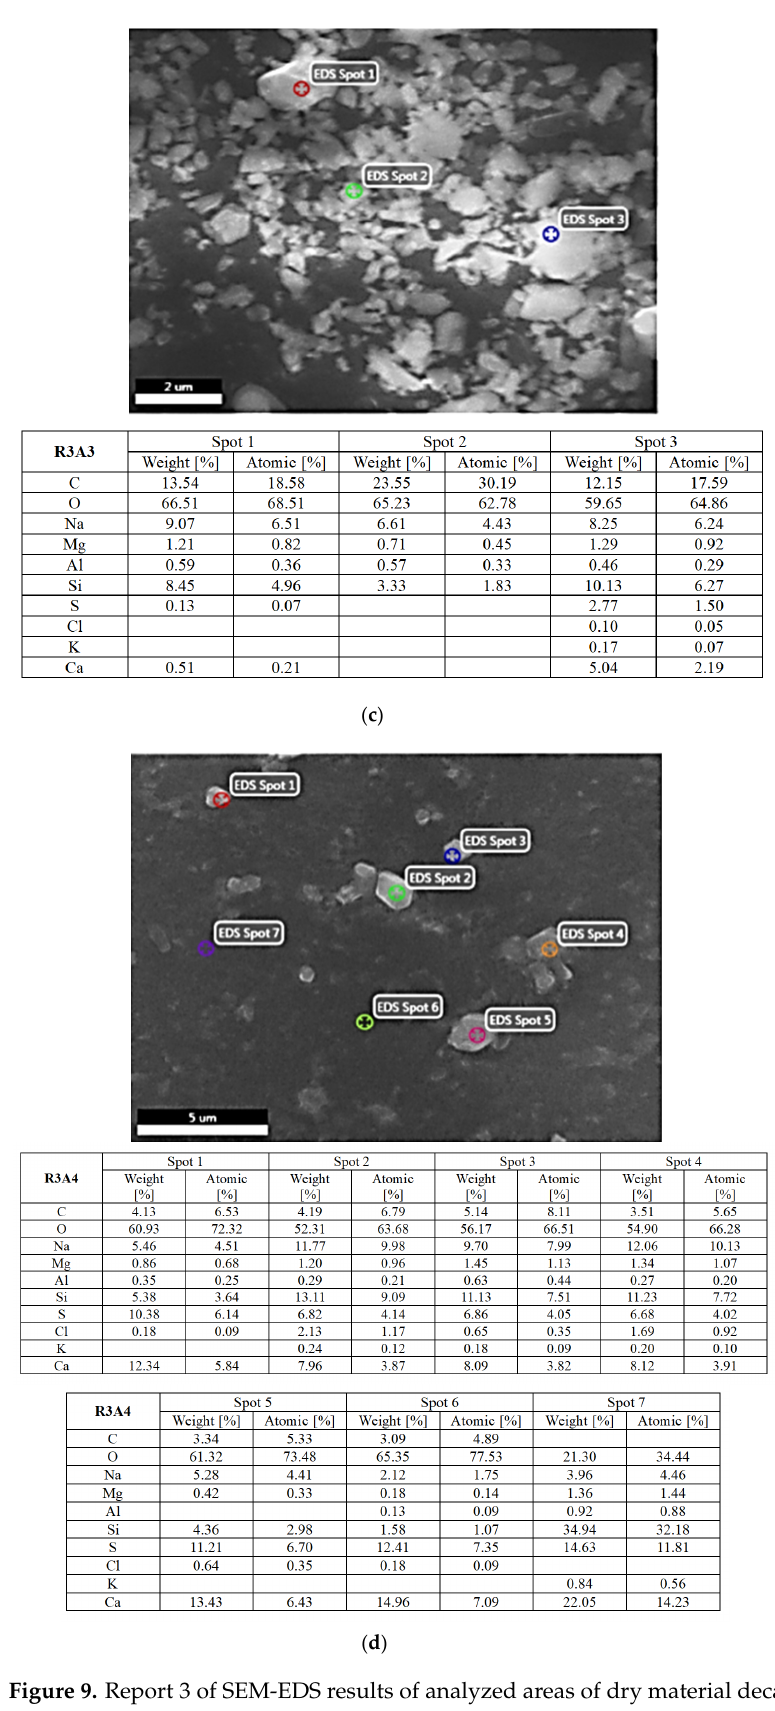
Figure 9. Report 3 of SEM-EDS results of analyzed areas of dry material decanted from rainwater: ( a ) R3A1; ( b ) R3A2; ( c ) R3A3; ( d ) R3A4.